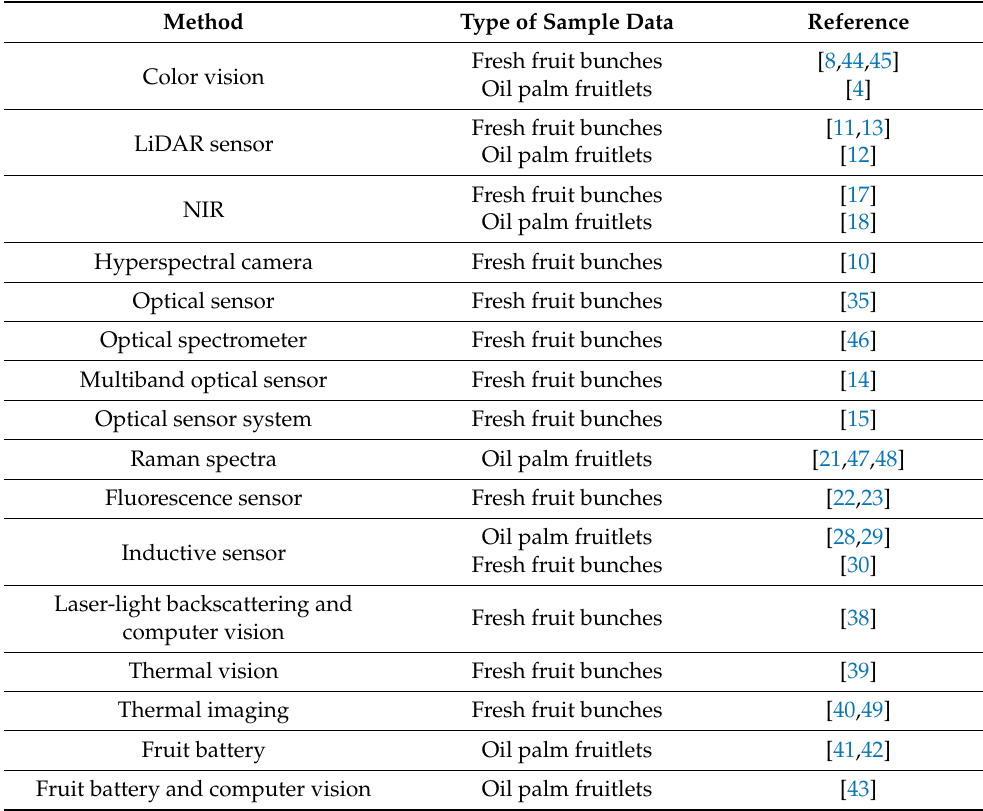
Table 1. Type of sample data used with every